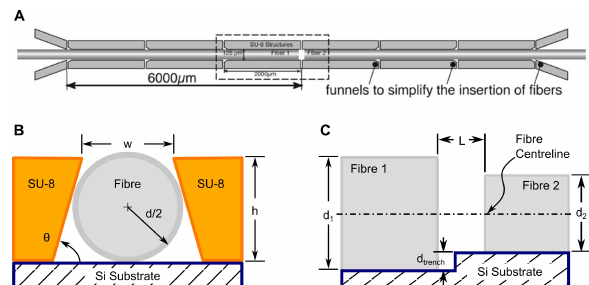
Fig. 14. (A) Top view of a fiber alignment structure (Source: [72]). (B) To effectively grip the fiber in the alignment structure and minimize out of plane movement, the SU-8 structure should be high enough and at an angle less than 90 ∘ with respect to the substrate. The un- dercut in the SU-8 is achieved by tailoring the exposure, proximity gap, development, and bake parameters in the lithographic pro- cess. (C) To align fibers with different diameters, a channel of depth d trench = ( d 1 − d 2 ) /2 can be etched in the substrate on one side of the chip